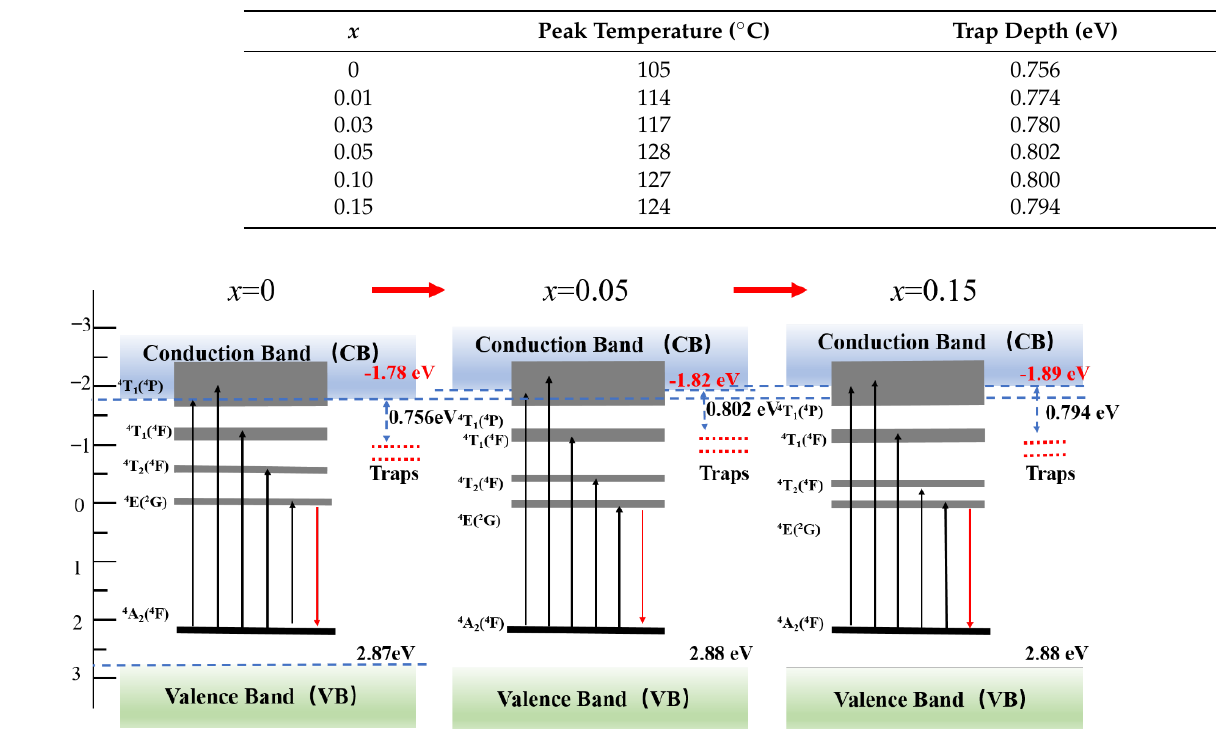
Table 2. Main peak temperatures of the TL glow curves and estimated trap depths.